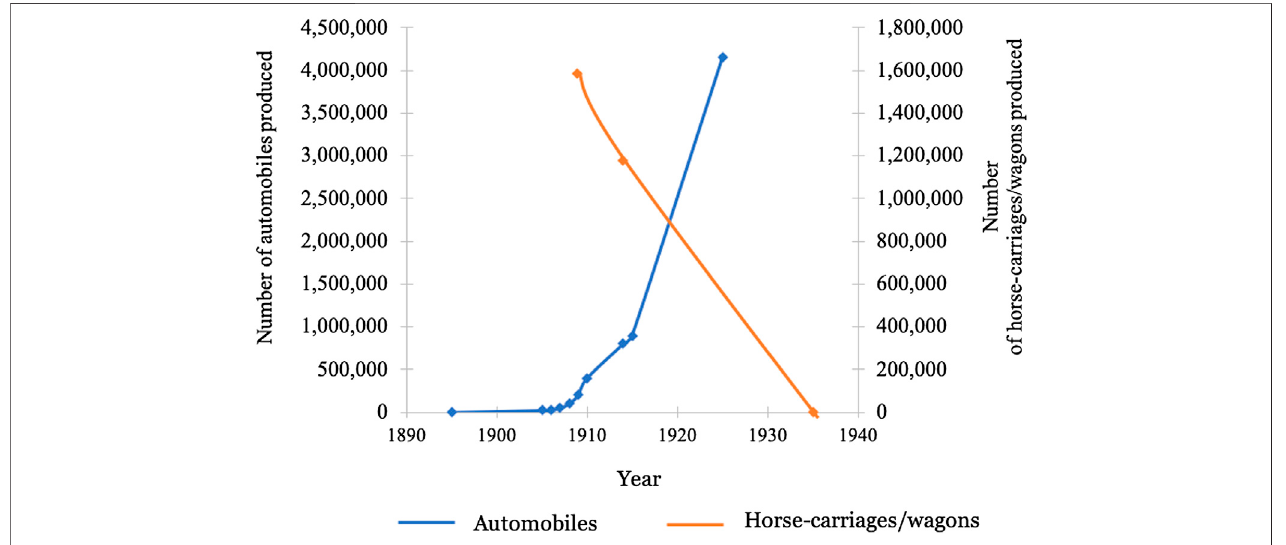
Frontiers in Energy Research |